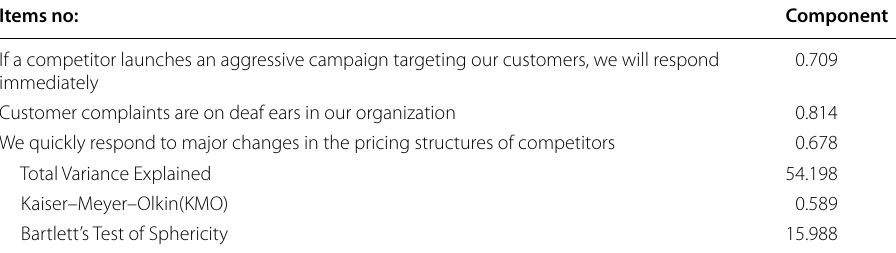
Table 4 Factor analysis focus on customer response